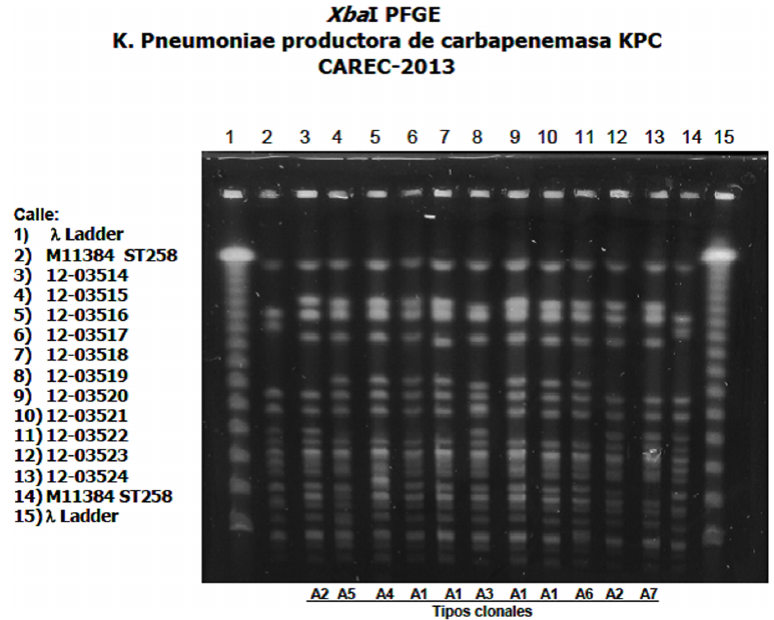
Fig 1. PFGE for molecular typing of selected samples showing similarities in band patterns across each